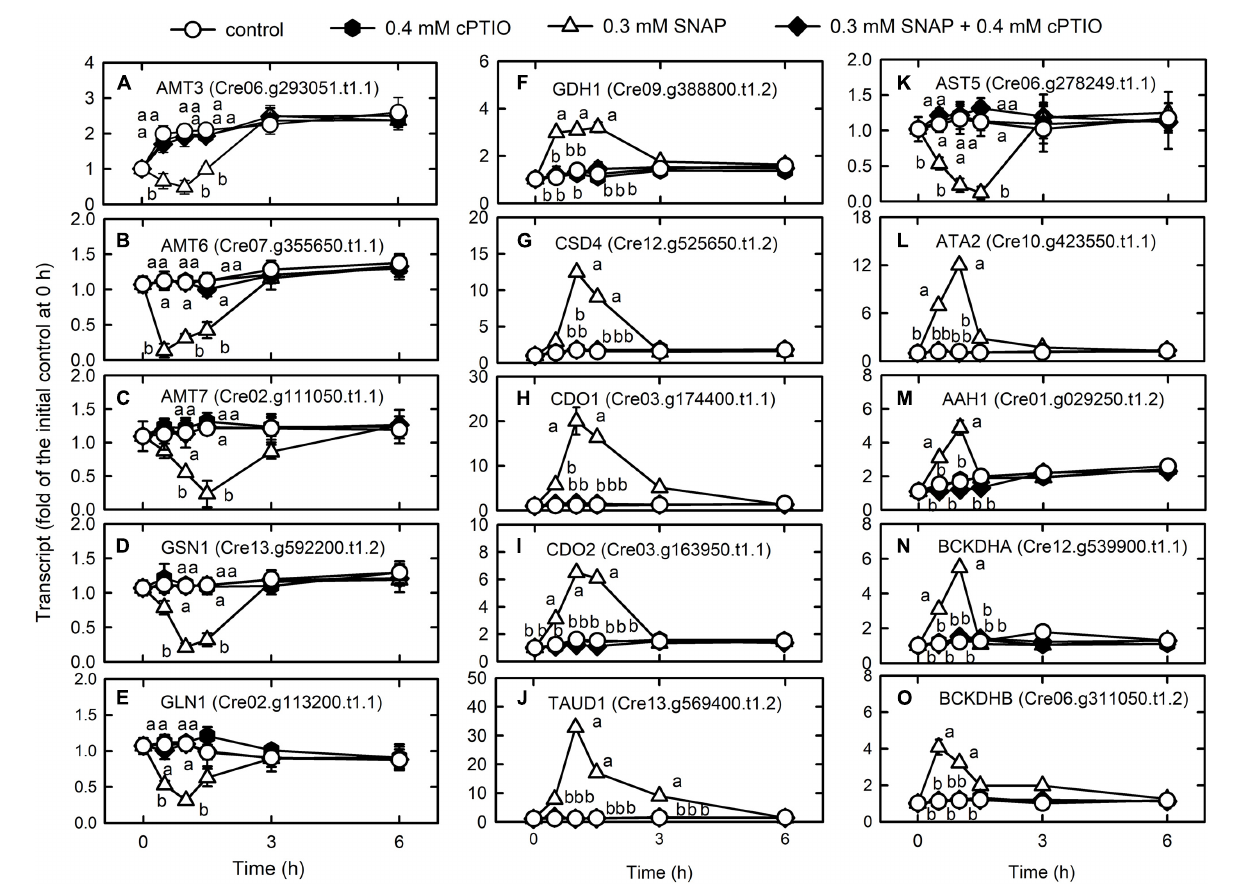
FIGURE 4 | Effects of NO on the expression of genes encoding proteins associated with nitrogen metabolism. Time-course changes in the transcript abundances of AMT3 (A) , AMT6 (B) , AMT7 (C) , GSN1 (D) GLN1 (E) , GDH1 (F) , CSD4 (G) , CDO1 (H) , CDO2 (I) , TAUD1 (J) , AST5 (K) , ATA2 (L) , AAH1 (M) , BCKDHA (N) , and BCKDHB (O) in C. reinhardtii in response to 0.3 mM SNAP in the presence or absence of 0.4 mM cPTIO. Data are expressed as the mean ± SD ( n = 3). Different symbols indicate significant differences between treatments (Scheffe’s test, P <